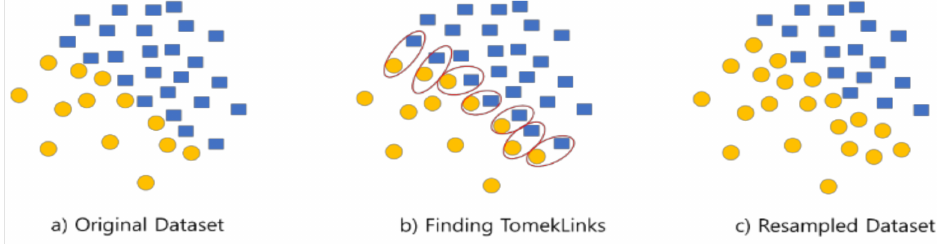
Figure 1. Creation of TomekLinks.